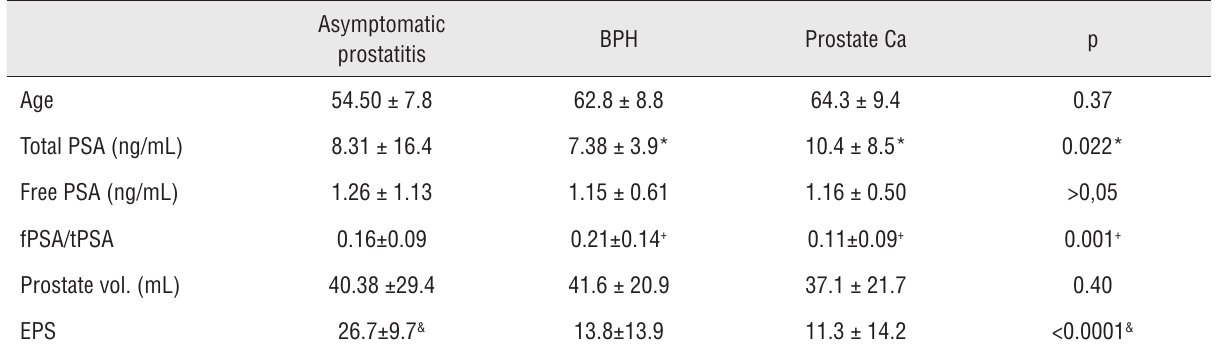
Table 1 - General features of the Patients and